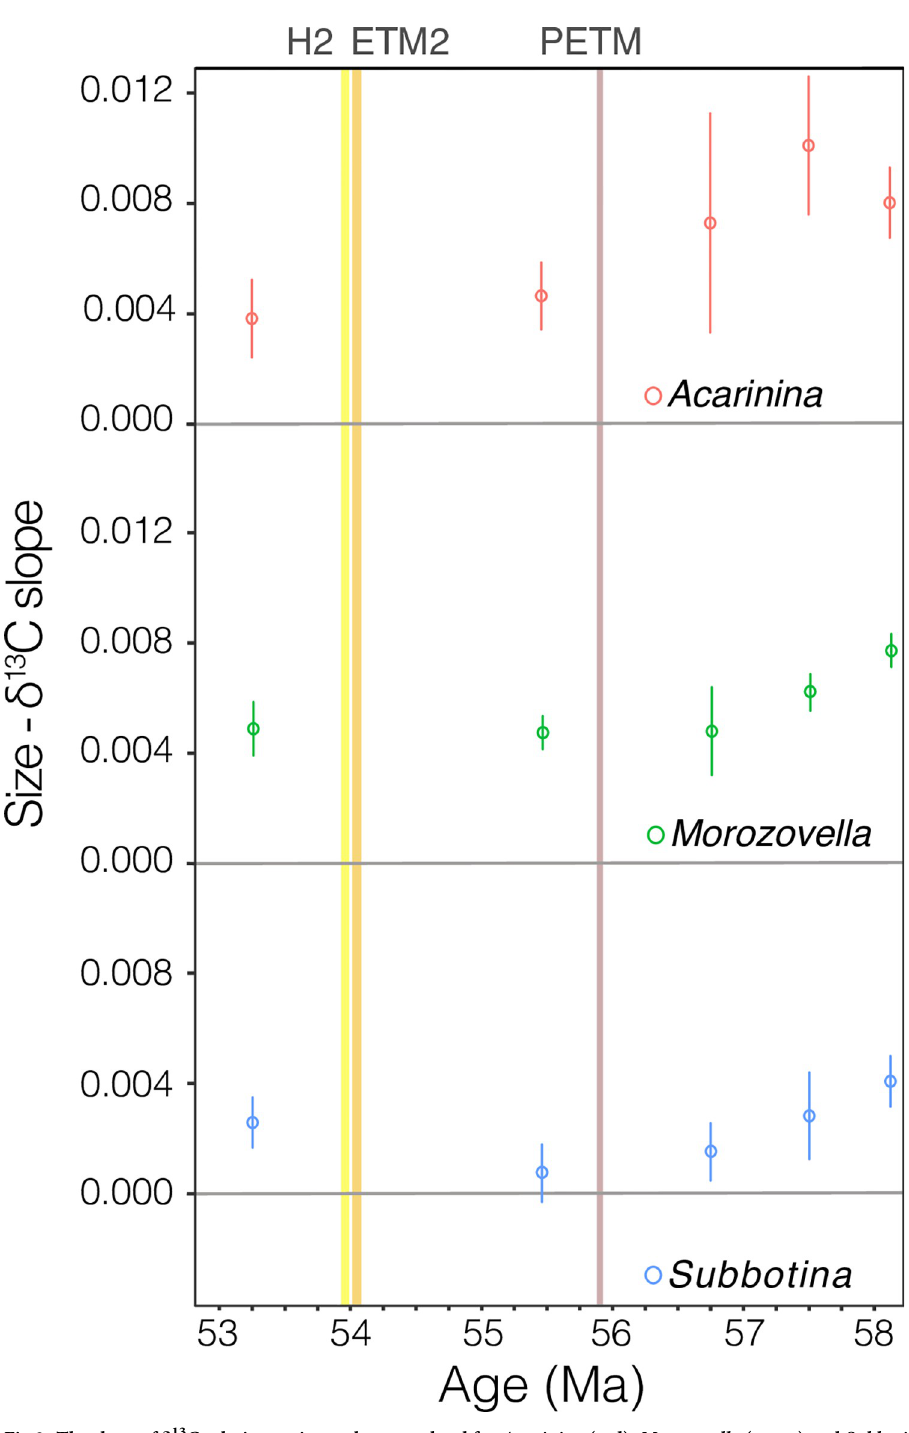
Fig 3. The slope of δ 13 C relative to size at the genus level for Acarinina (red), Morozovella (green) and Subbotina (blue) species from ODP Site 577, after [19], rescaled to the age model of [41] and shown as open circles with error bars. The H2, ETM2, and PETM intervals are designated with yellow, orange, and brown shading respectively.